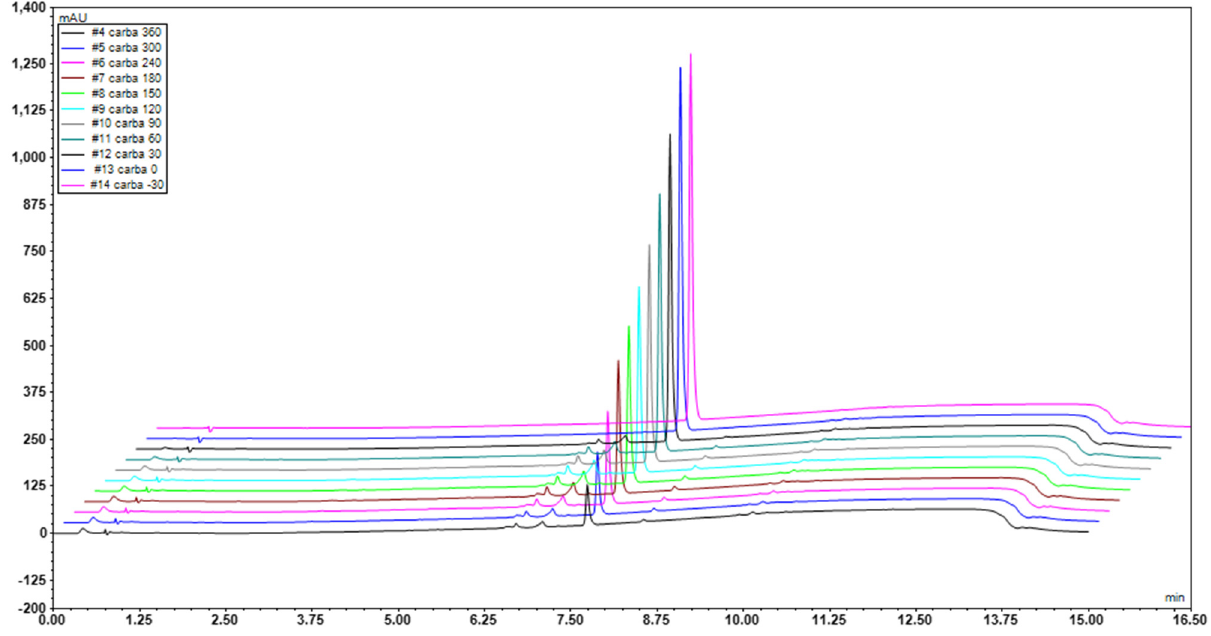
Figure 6. Chromatogram by HPLC of the degradation process of CBZ.